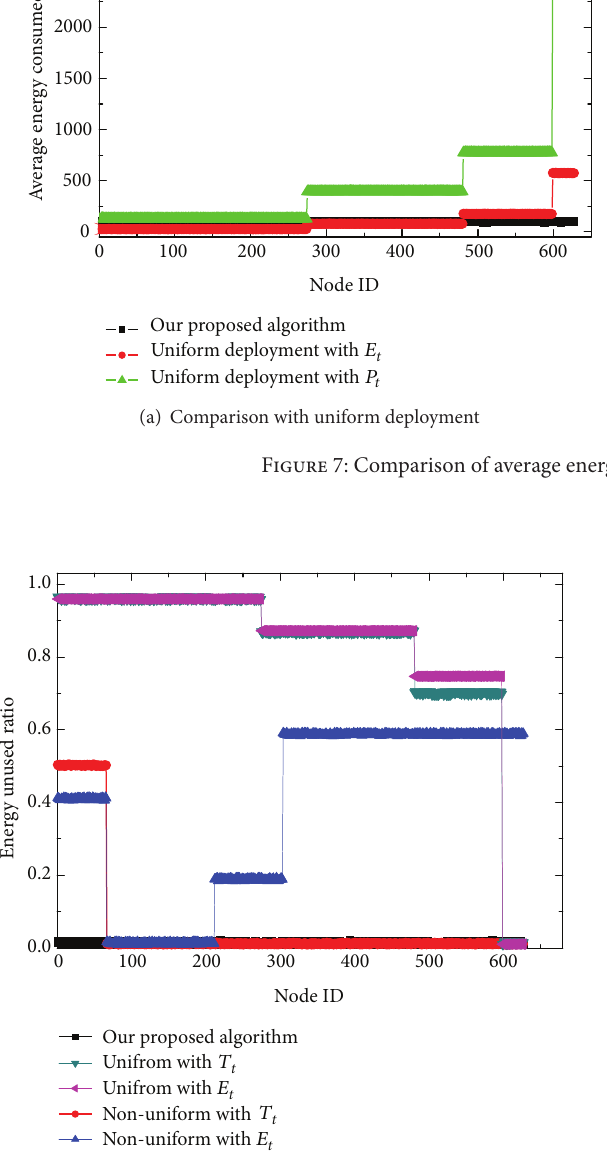
Figure 8: Comparison of energy unused ratio for each node.